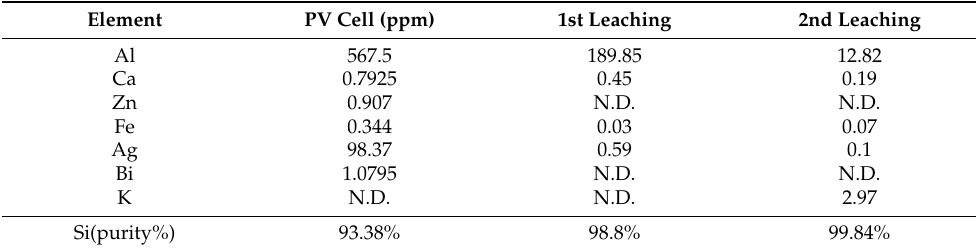
Table 2. The concentration of metal impurity in silicon purification